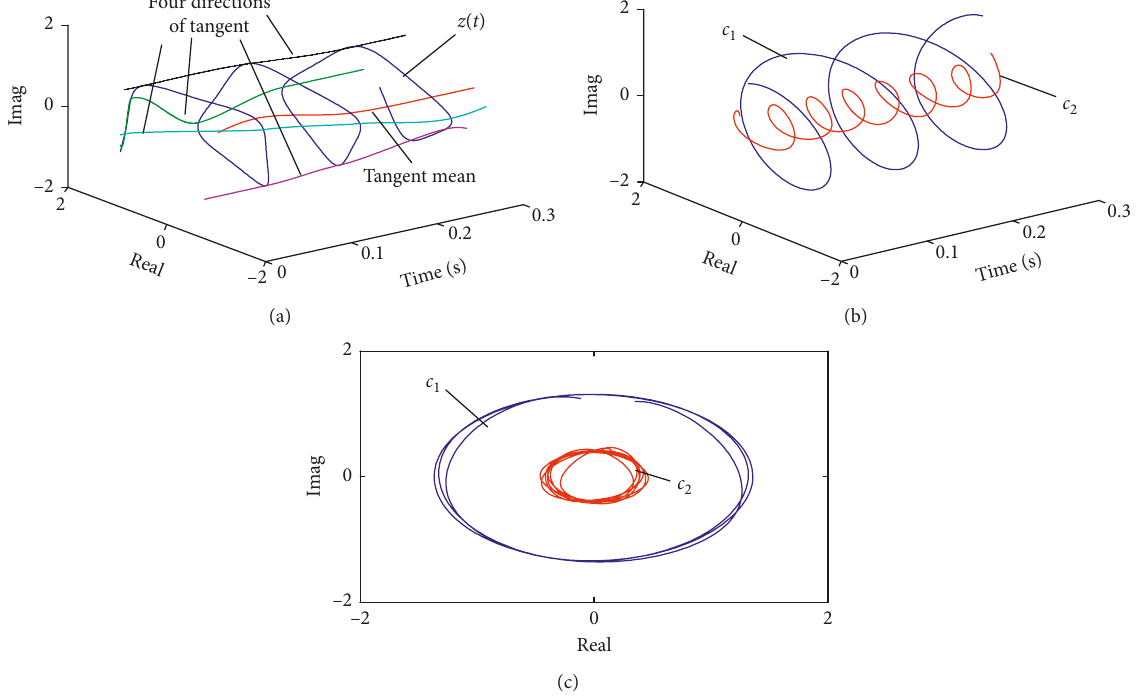
Figure 2: (a) z t and its four directions of the tangent and tangential mean; (b) the decomposition results of z ( ) the planes of c 1 and c 2